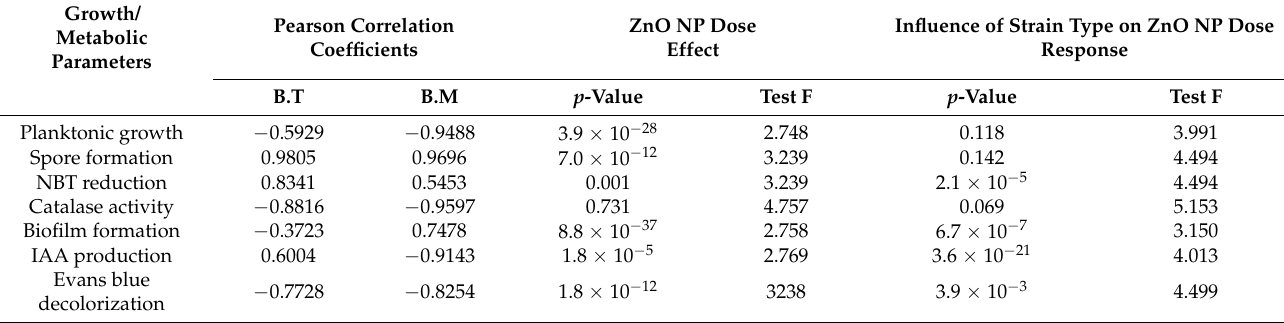
Table 1. Pearson correlation coefficients and ANOVA showing the effect of ZnO NPs on selected parameters of the growth and metabolic activity of Bacillus spp.